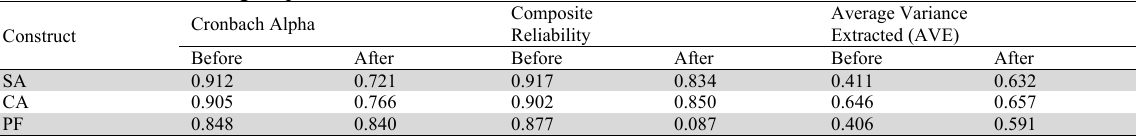
Standardized factor loading, Alpha Cronbach, and AVE Construct